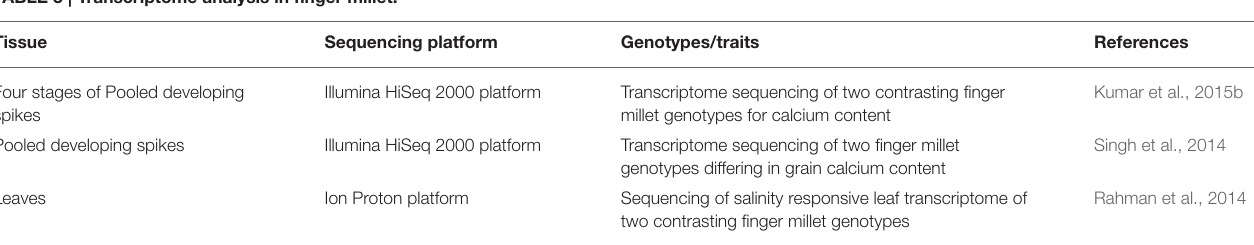
TABLE 3 | Transcriptome analysis in finger